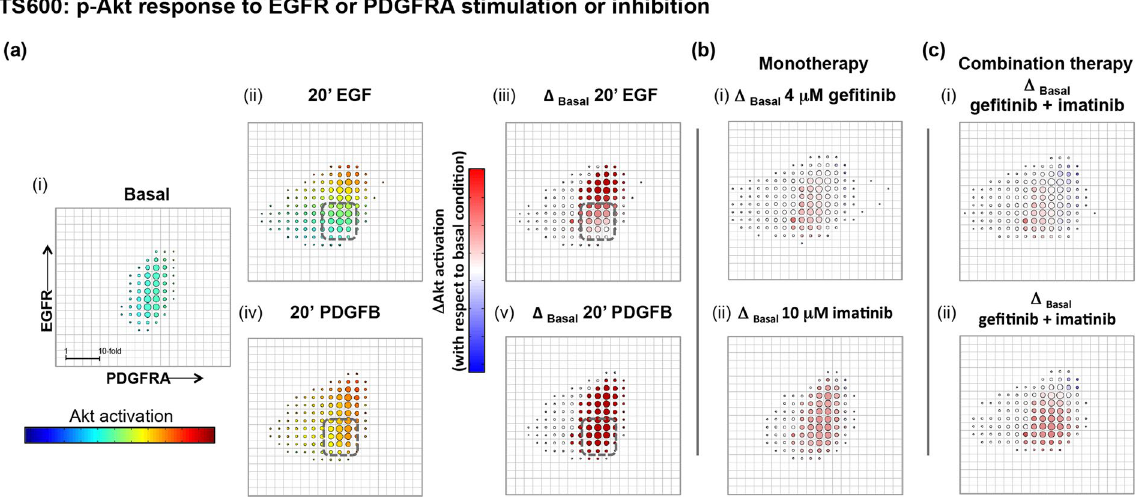
Figure 3. Balance of RTK expression determines tumorsphere p-Akt response to ligand and pathway inhibitors. Multichannel p-FACS experiments in TS600 were analyzed to generate heatmaps of p-Akt activation as a function of EGFR and PDGFRA expression. Mean normalized p-Akt levels for cells in each bin are represented by a rainbow color map, and changes in mean from basal levels are represented by blue/white/red color map with a scale of + / − 10-fold change (scale bar shown in “Basal” condition), where red and blue cell bins in the presence of RTK inhibitor indicates more resistant and sensitive cell subpopulations, respectively. Circle size corresponds to number of cells per bin. ( a ) Ligand effect on p-Akt. (i, ii iii) EGF stimulates p-Akt along a gradient of EGFR expression and appears to have little effect on cells harboring low-level receptor expression (dashed box). EGFR and p-Akt levels were positively correlated (ii, iii: correlation coefficient = 0.72) (i, iv, v) PDGFB stimulates p-Akt in all cell bins. The subset of cells with low EGFR expression was responsive to PDGFB ligand at the concentrations tested. ( b ) Mono- and ( c ) combination RTK inhibitor treatment effect on p-Akt: Treatment with either (i) 4 μ M gefitinib or (ii) 10 μ M imatinib or (c) dual inhibition in the presence of ligand reduced p-Akt levels to basal levels or below in cells with higher RTK expression but failed to inhibit low- expressing